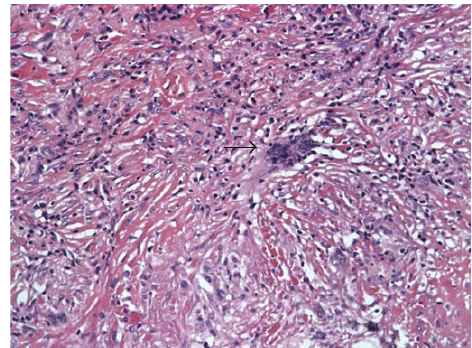
Figure 4: Multinucleated giant cells with lymphocytes, fibroblasts, and collagen in the granuloma